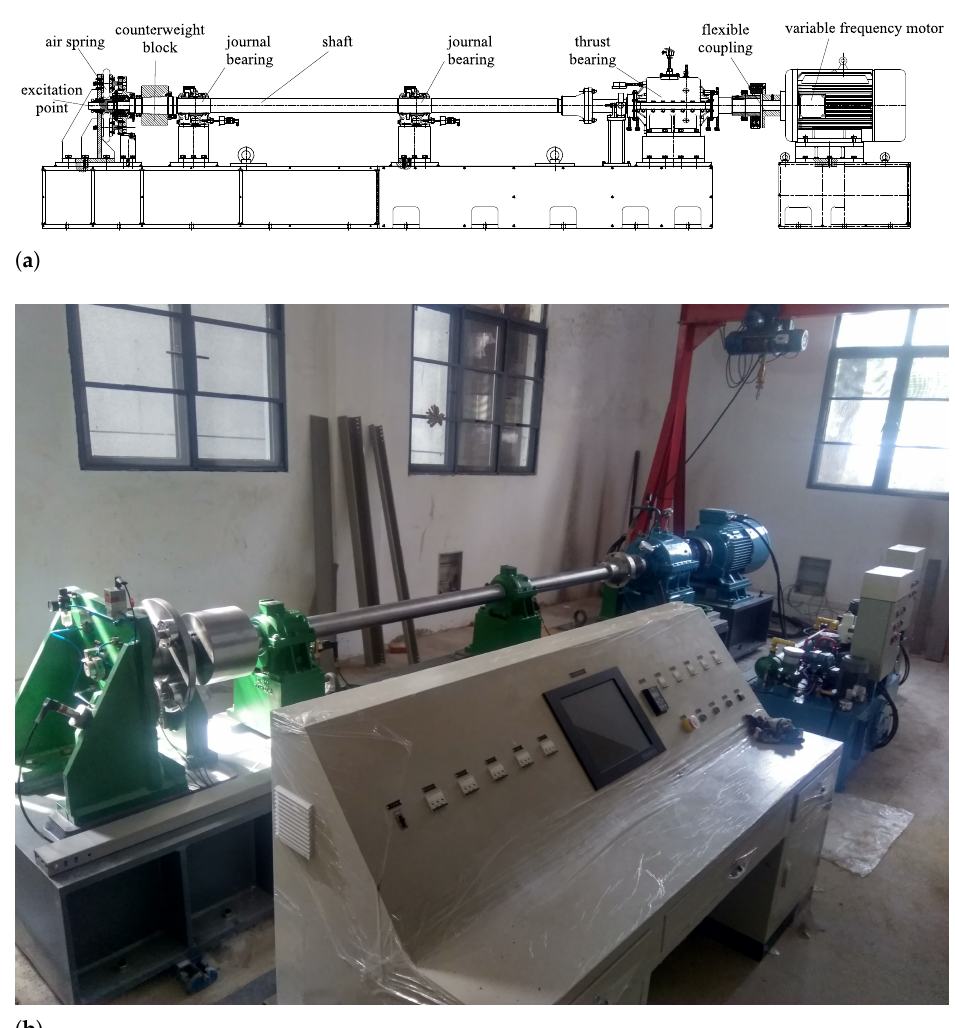
Figure 1. Test rig: ( a ) structure drawing; ( b ) real picture. The test rig simulates propeller propulsion using parallel static and dynamic forces. The air spring mounted on the stern provides static thrust, and its value can be adjusted by changing the airbag pressure. Dynamic forces were excited by force hammers, which also act on the stern end to simulate propeller excitation forces. To achieve the simultaneous transfer of static and dynamic forces to the rotating shaft, we designed a tapered ball bearing between the shaft and the air spring device to solve the connection problem between the rotating and the non-rotating shaft. Compared to using a propeller, the parallelism of static and dynamic forces allows the static thrust and rotational speed to be changed independently for the vibration